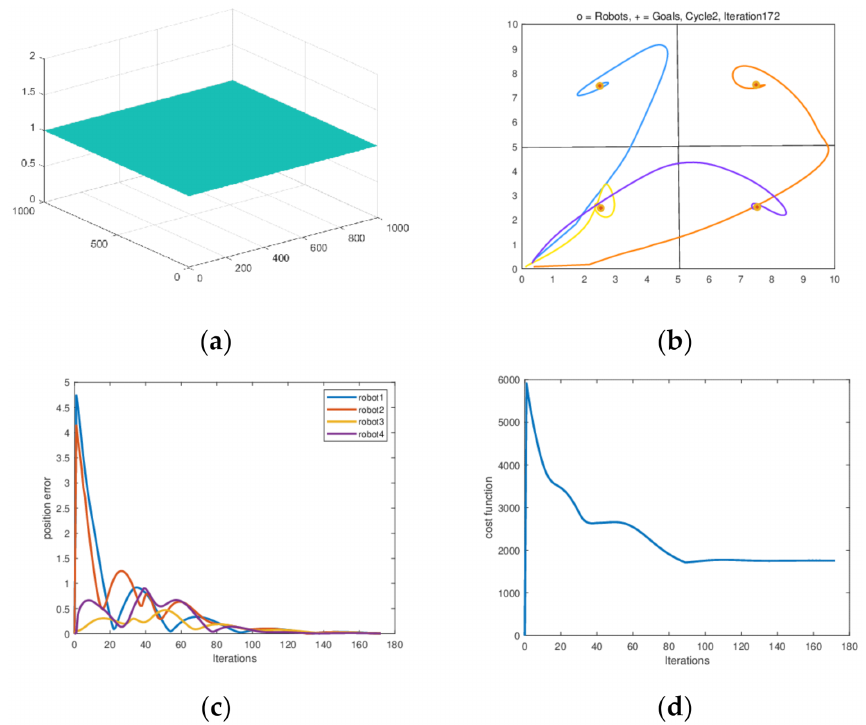
Figure 5. Multi-robot square formation simulation: ( a ) density function distribution; ( b ) square formation; ( c ) position error; ( d ) cost